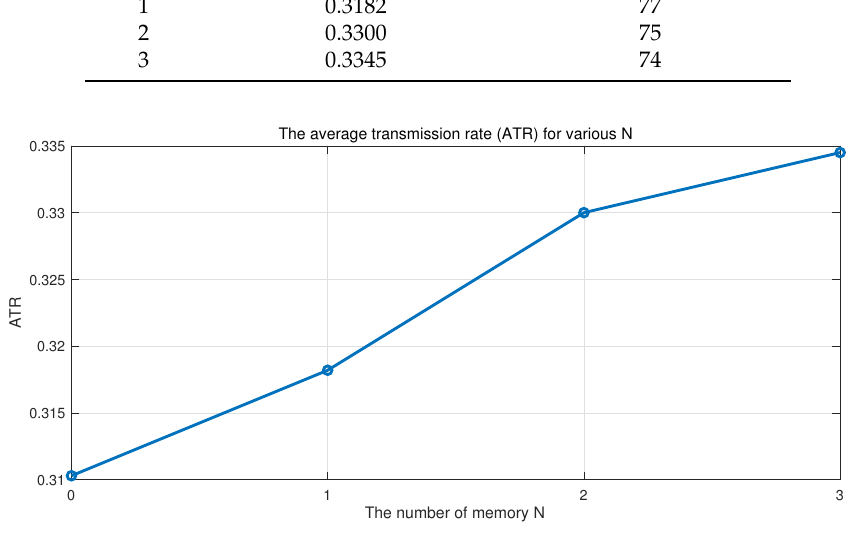
Figure 9. The average transmission rate for